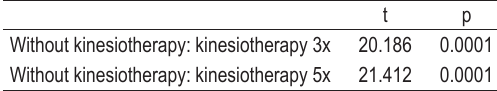
Total 90 −10.7667 SD: Standard deviation; SE: Standard error TABLE 7. Comparison of the average values of the Oswestry Disability Index differences between the groups, before and after treatment (Student t‑test)